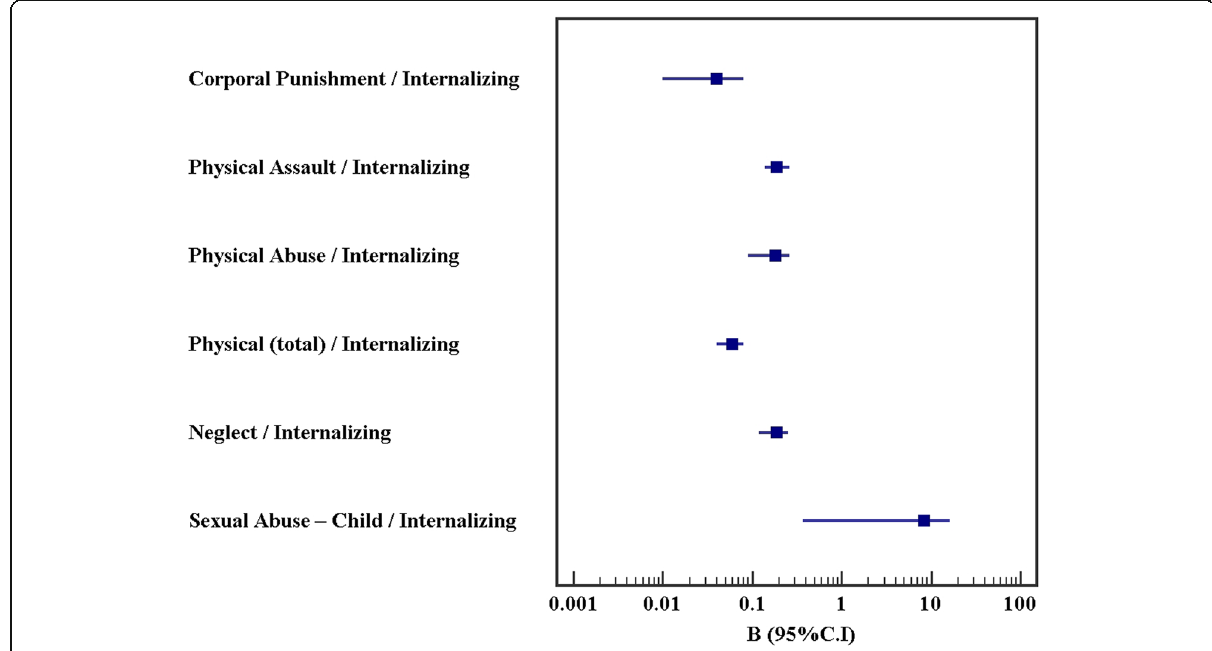
Fig. 1 Univariate linear regression for predictor variables significantly affecting CBCL internalizing problems